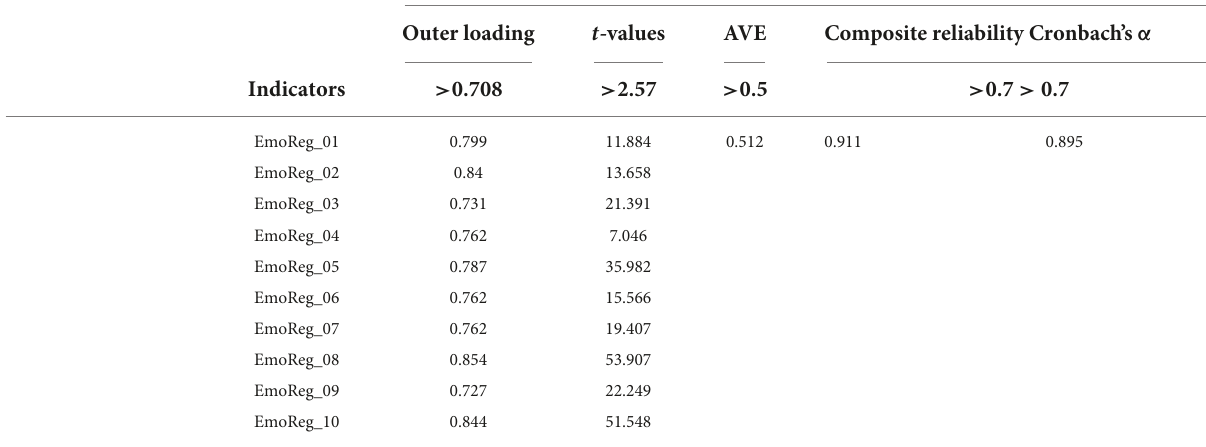
TABLE 2 Cronbach’s alpha, composite reliability, and convergent validity of emotion regulation. Emotion